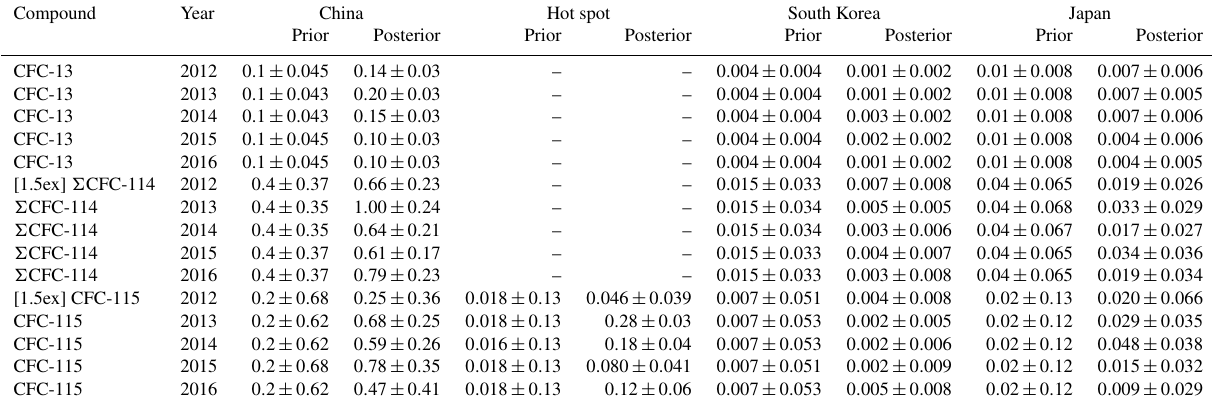
Table 2. By-country emissions of CFC-13, (cid:54) CFC-114, and CFC-115, estimated by the regional inversion: prior and posterior estimates. Emissions from areas with HFC-125 factories are termed “hot spot”. All values are given in units of ktyr − 1 ; uncertainties represent a 1 σ range. Compound Year China Hot spot South Korea Japan Prior Posterior Prior Posterior Prior Posterior Prior